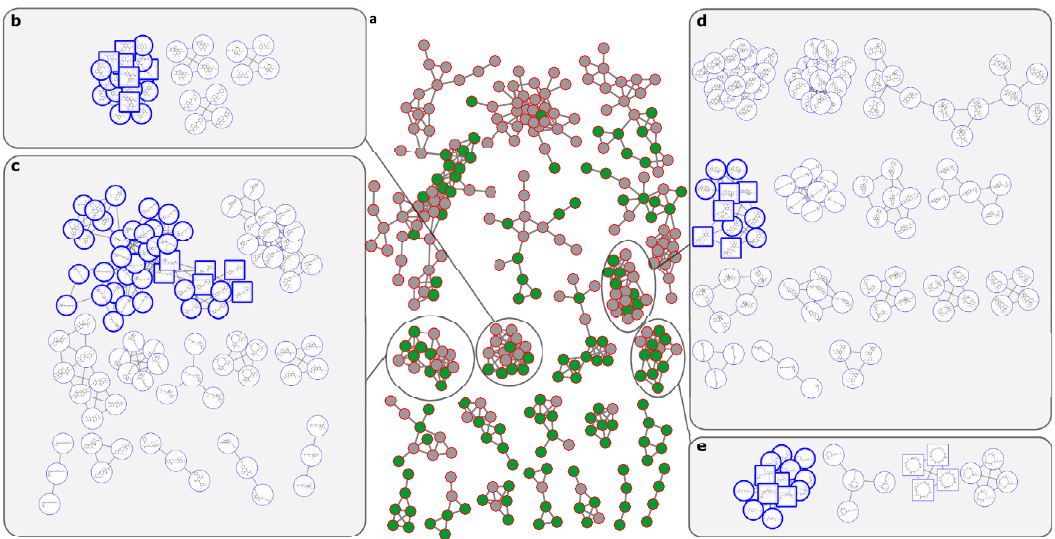
Fig. 4 | EvaluationofSNAP-MSusing a molecular network built fromreference spectra.a Subnetworks from amolecularnetworkwere created from GNPS public spectrallibrariesNIHNaturalProductsLibrary1andNIHNaturalProductsLibrary2. Nodescorrespondingtocompounds presentinthe NaturalProductsAtlascolored